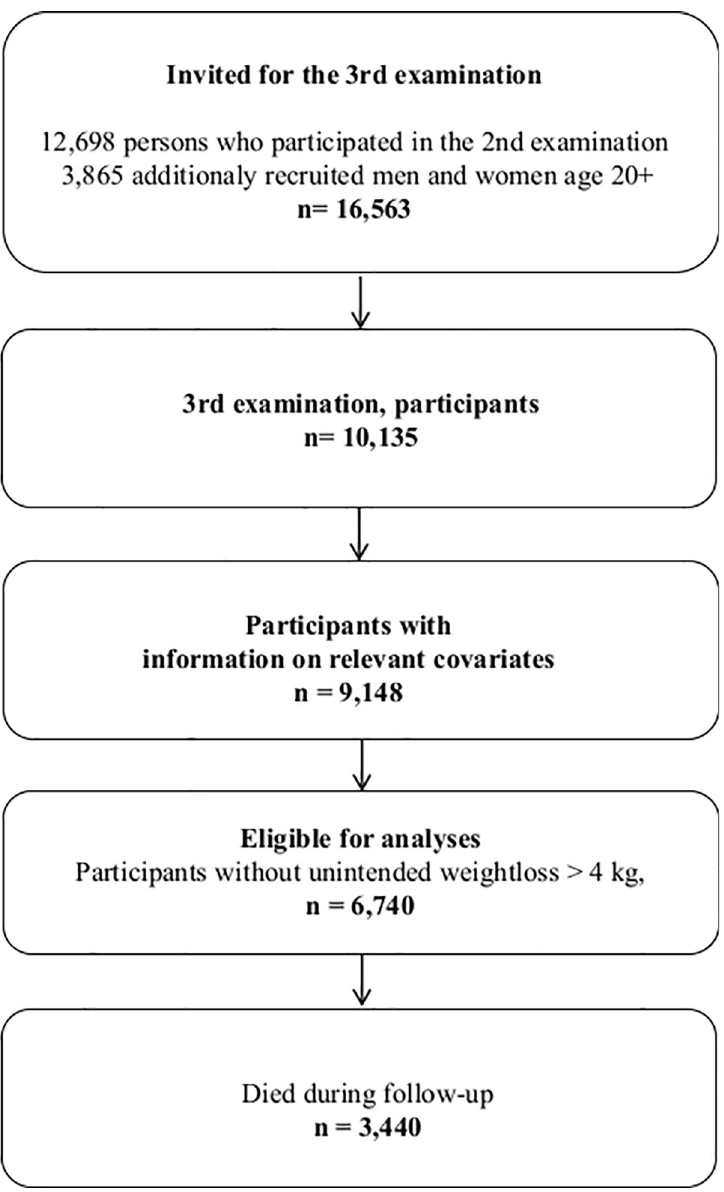
Fig 1. Flow chart depicting the construction of the eventually eligible study sample out of the original cohort of the Copenhagen City Heart Study.